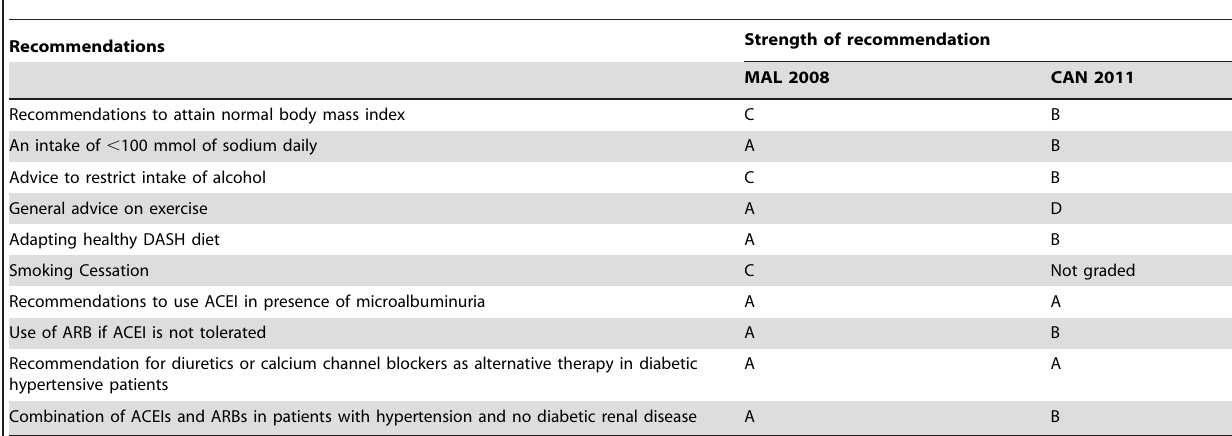
Table 4. Strength of the recommendations stated in the Malaysian and Canadian Clinical Practice Guidelines.*